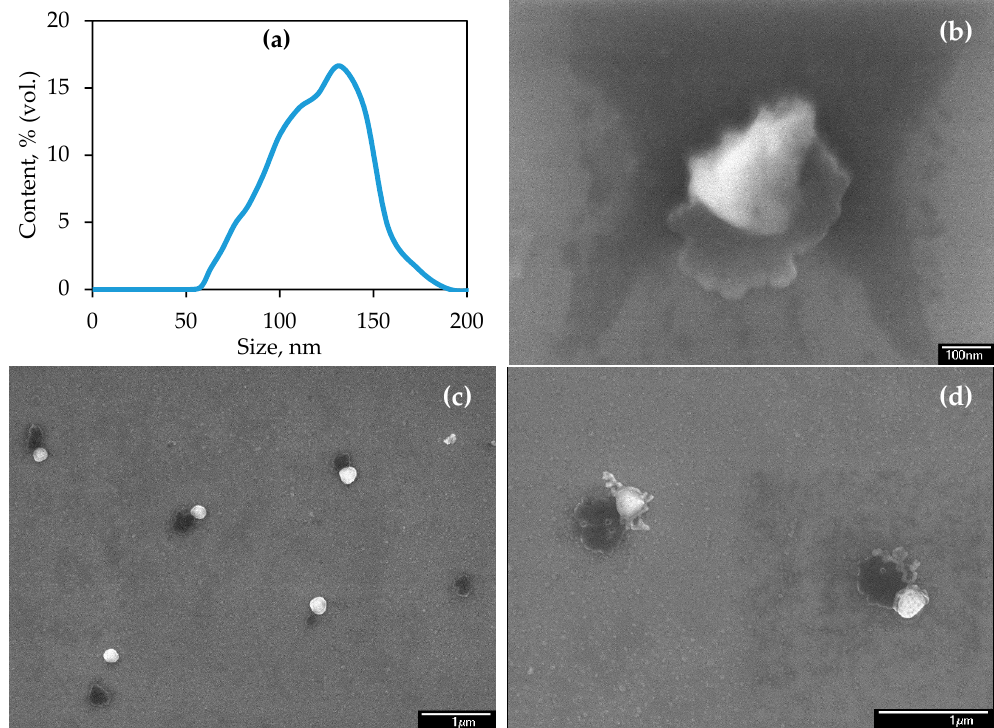
Figure 5. Size distribution of particles in the soil leachate ( a ). Micrographs of aggregates of CeO 2 (brighter) and mineral (darker) NPs ( b ), their “tandems” ( c ), and “ensembles” ( d ) in the soil leachate.